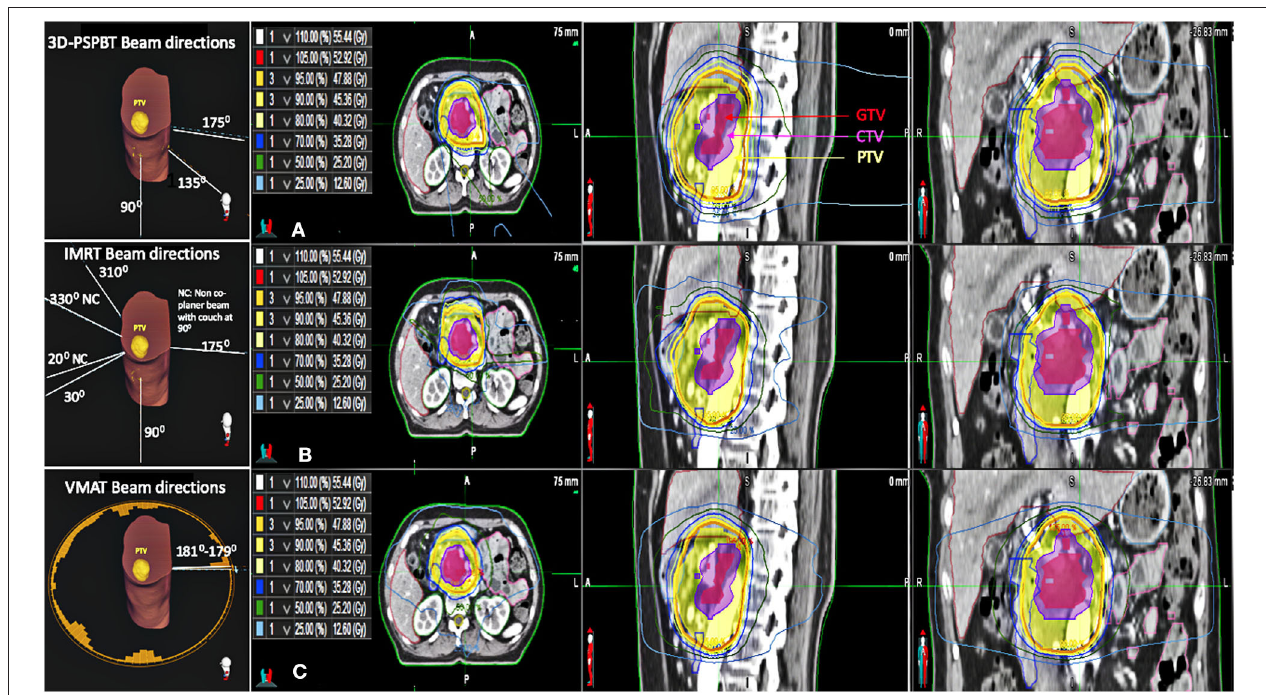
FIGURE 2 | Beam directions of all three plans for one representative patient. Axial, sagittal, and coronal CT slices showing the dose distributions of the (A) 3D-passive scattering proton beam therapy (3D-PSPBT) plan, (B) intensity-modulated radiotherapy (IMRT) plan, and (C) volume-modulated arc therapy (VMAT) plan for one representative